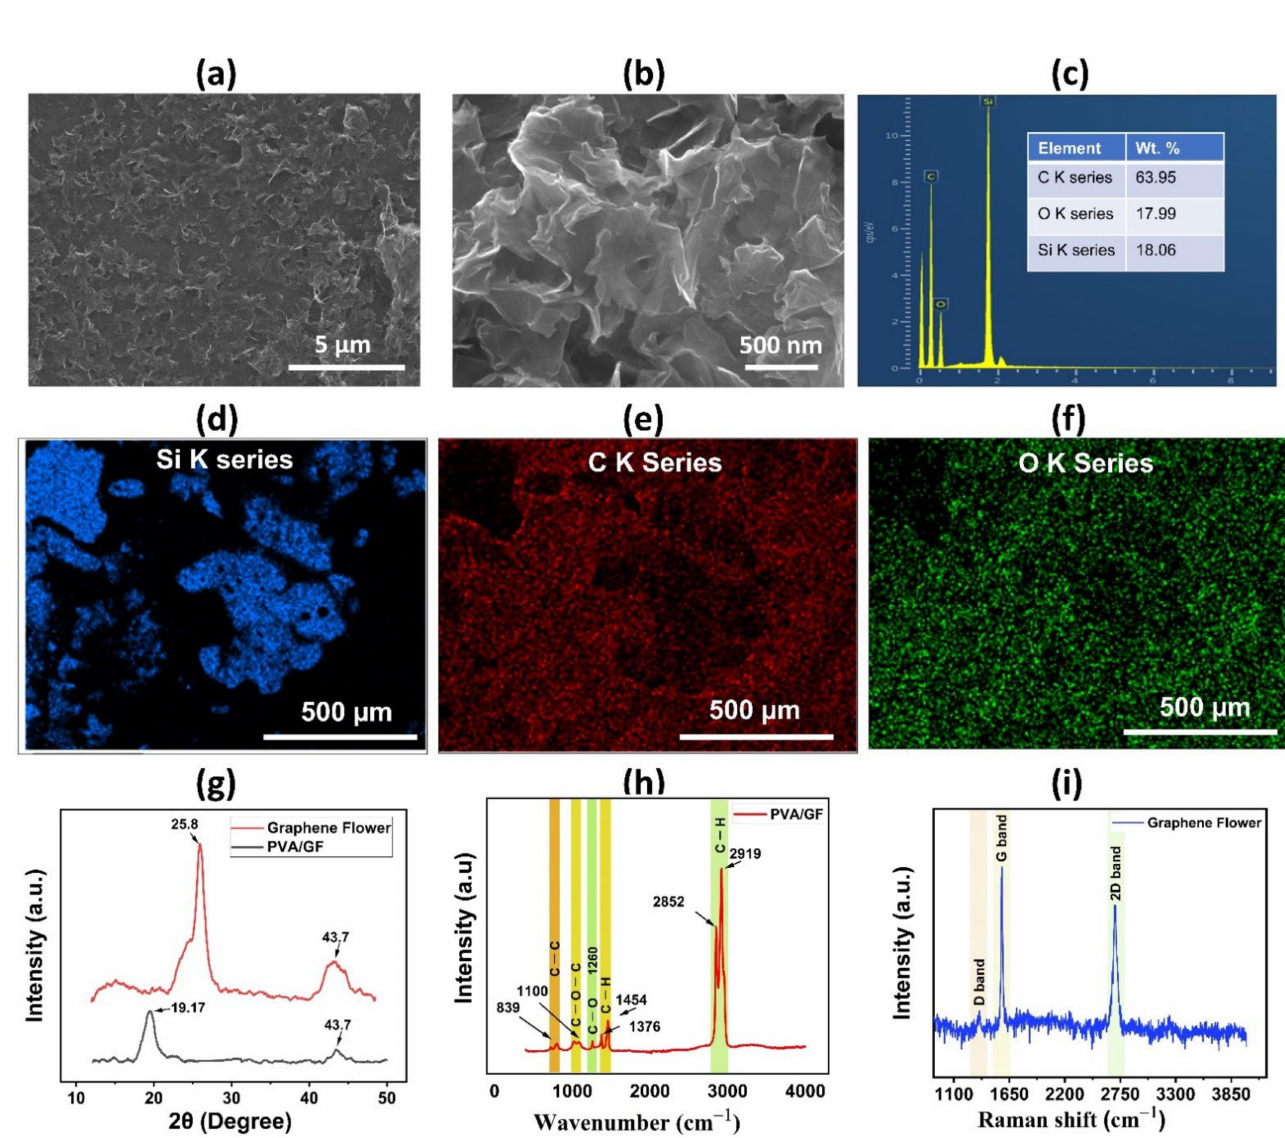
Figure 3. Sensor characterization ( a ) SEM image of the PVA/graphene flower composite thin film with resolution levels of 5 µ m. ( b ) SEM image of the PVA/graphene flower composite thin film with resolution levels of 500 nm. ( c ) EDS analysis of composite film. ( d ) EDS layered image. ( e ) O K series. ( f ) C K series of composite materials. ( g ) XRD analysis results of graphene flower, and PVA/graphene flower composite thin film. ( h ) Fourier transform infrared spectroscopy (FTIR) to characterize the composite layer materials. ( i ) Raman spectra of a graphene